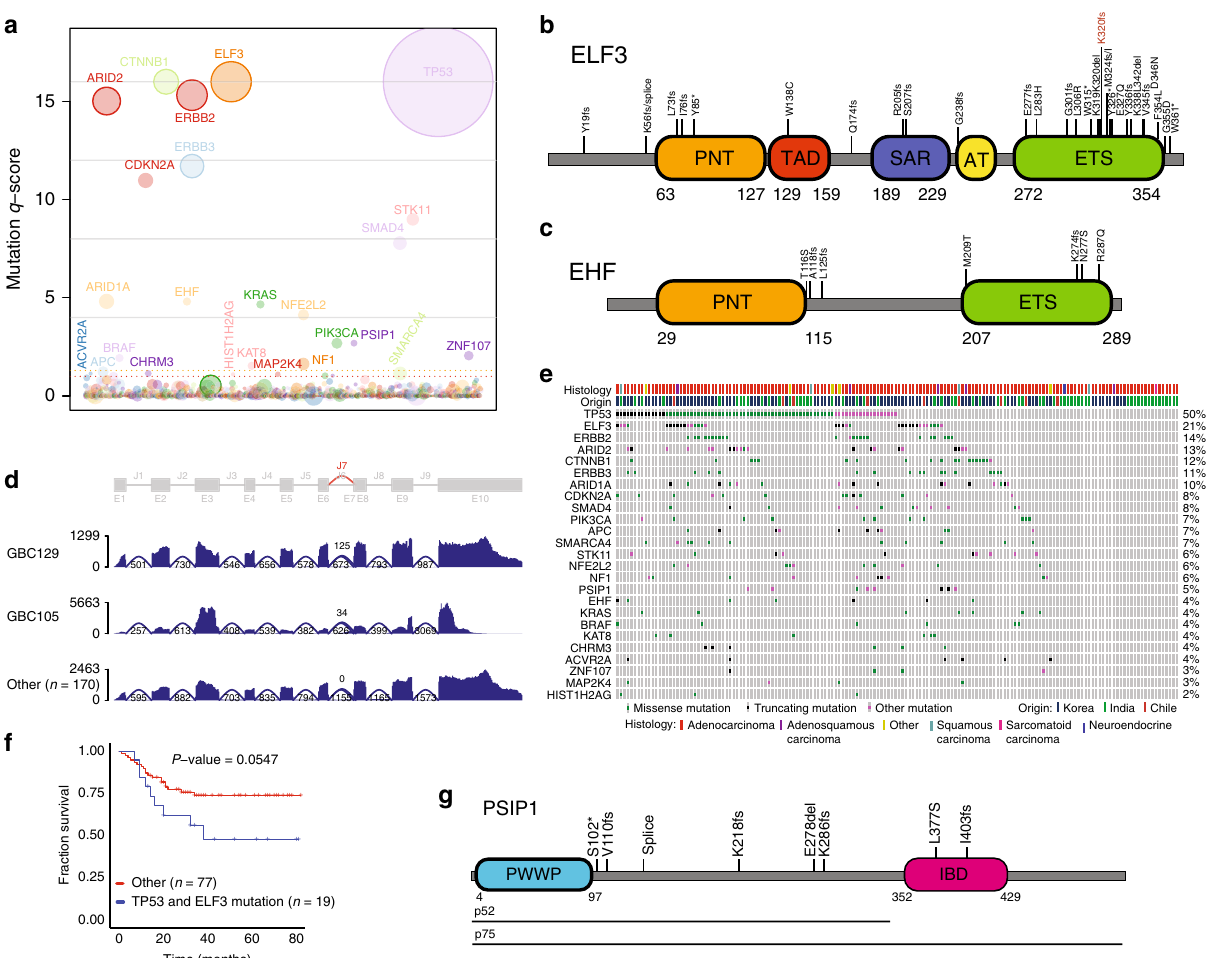
Fig. 2 Signi fi cantly mutated genes in GBC. a Plot showing the signi fi cantly mutated GBC genes and their q -score. Each gene is represented as a circle, where the size of the circle is proportional to the observed mutation frequency. Genes are arranged along the x axis in alphabetical order. Signi fi cant q - score genes with FDR < 0.1 are indicated. Dotted orange line, FDR = 0.05, dotted red line, FDR = 0.1. Schematics showing alterations in ETS family members ( b ) ELF3 and ( c ) EHF. d ELF3 splicing defects observed in two GBC samples. e Plot representing mutations observed in SMG genes across the GBC samples. Each column represents a sample. f Kaplan – Meier survival plot of patients with tumor double positive for ELF3 and TP53 vs others. Log-rank test p values are presented for each group. g Schematic showing alterations observed in PSIP1 in